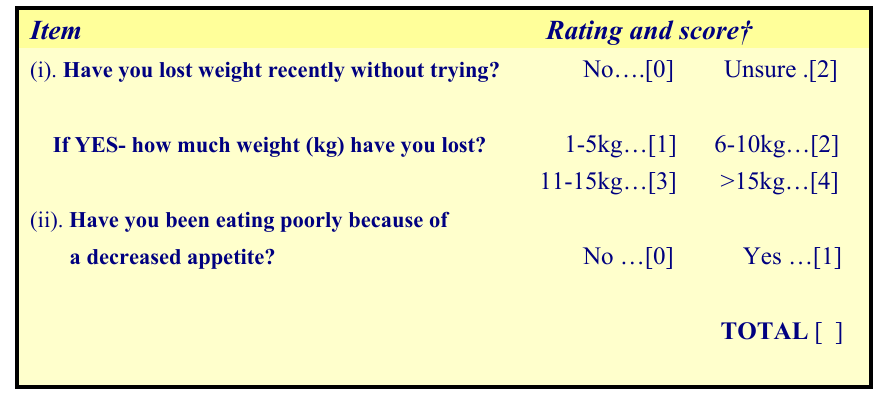
Figure 1. Malnutrition Screening